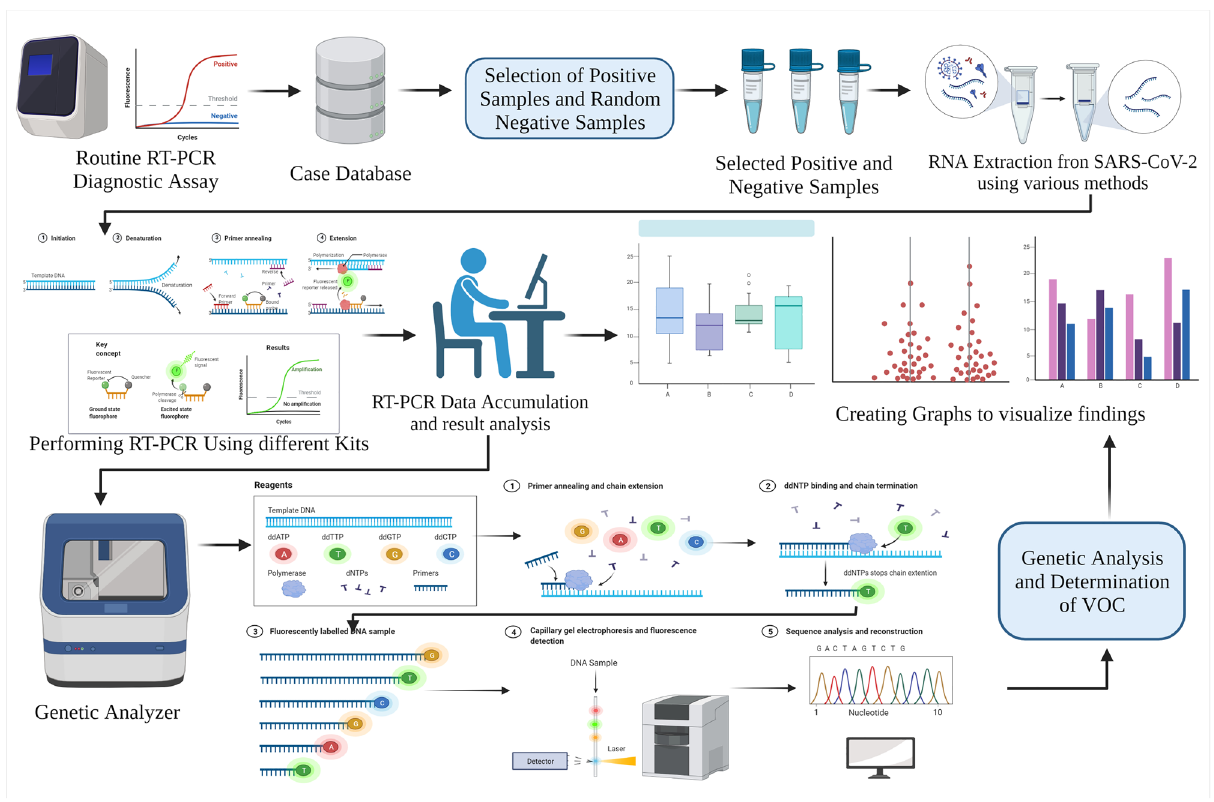
Figure 1. Schematic Workflow of the Evaluation of RT-PCR Assays in detection of SARS-CoV-2 Variant of Concerns. The Upper Portion depicts the sample selection and extraction procedure and the lower portion shows the overall workflow from performing RT-PCR to Data analysis. RT-PCR, Real-Time Polymerase Chain Reaction; VOC, Variant of concern; SARS-CoV-2, Severe Acute Respiratory Syndrome